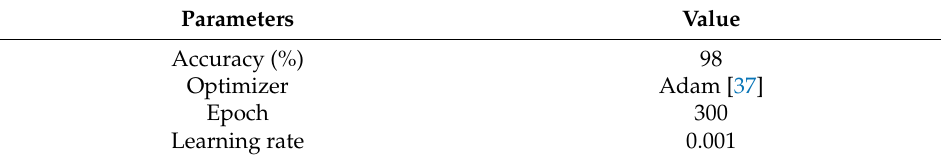
Table 9. Dialog act classification details.